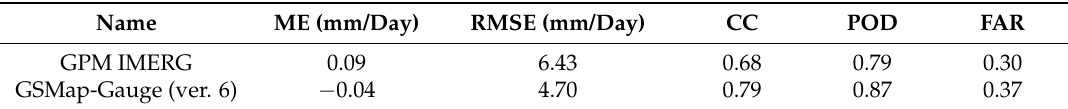
Table 5. Validation statistics of the two precipitation estimates over mainland China from April 2014 to November